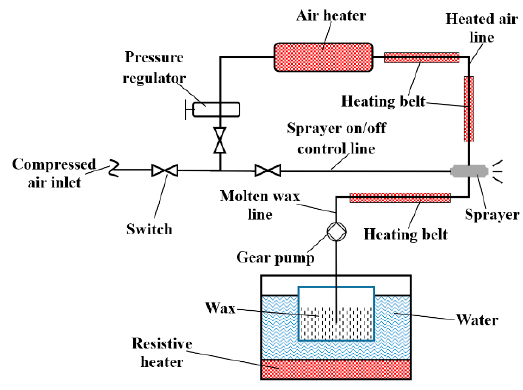
Figure 3. Schematic of the wax spray system.